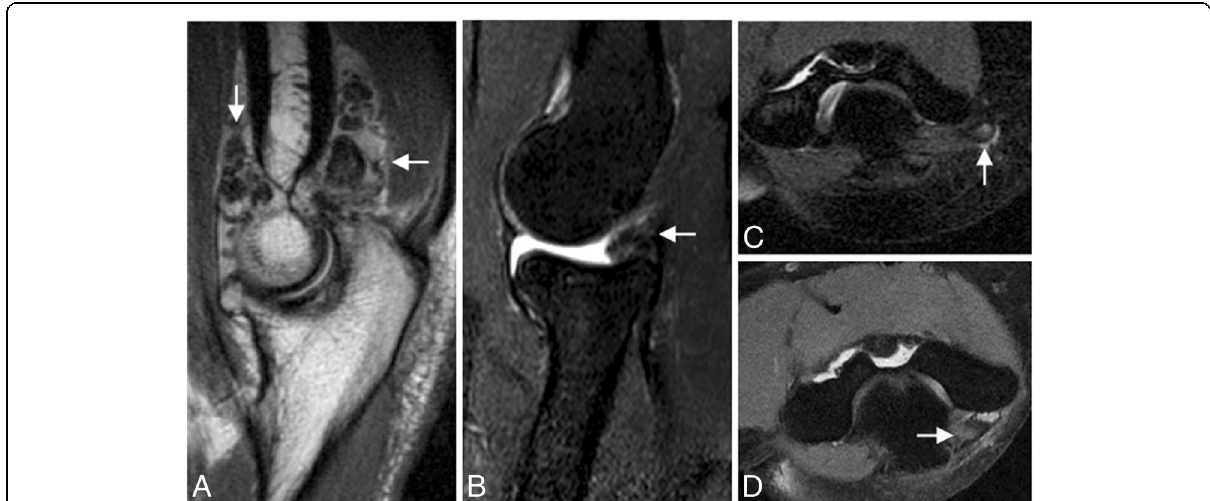
Fig. 34 Four different patients with recurrent painful click in the elbow. Sagittal T2-weighted MRI ( a ), sagittal FS PD-weighted MRI ( b ), axial FS PD-weighted MRI ( c ), and axial T1-weighted MRI ( d ) showing synovial osteochondromatosis ( a ), a posterolateral plica ( b ), an ulnar nerve subluxation ( c ), and hypertrophy of the medial head triceps ( d )